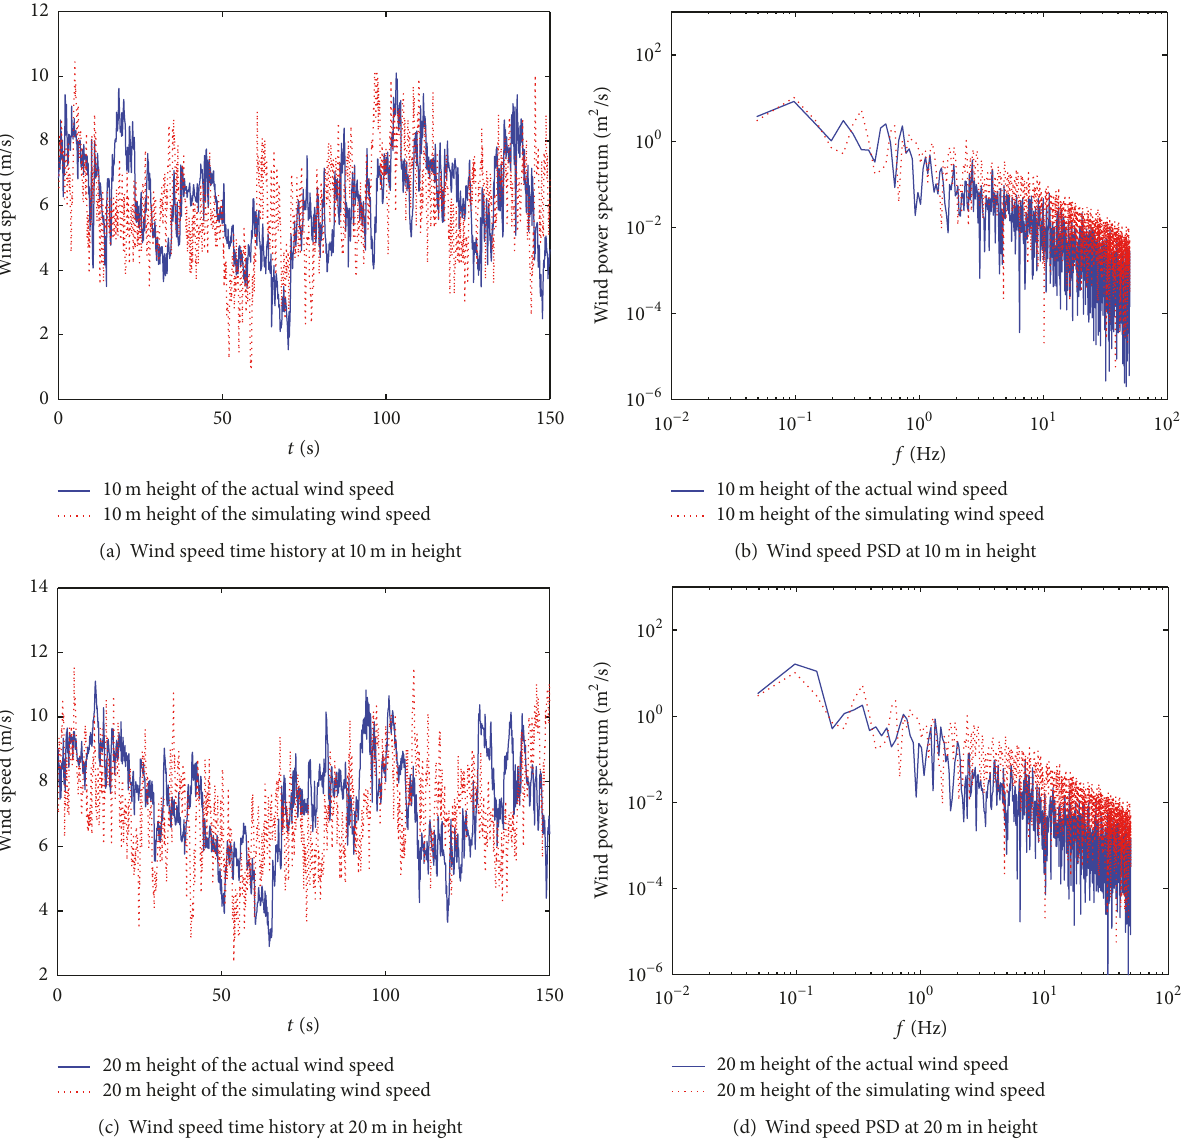
Figure 11: Comparison of the simulated results and the field measurements of wind velocity at heights of 10 and 20 m on transmission tower number